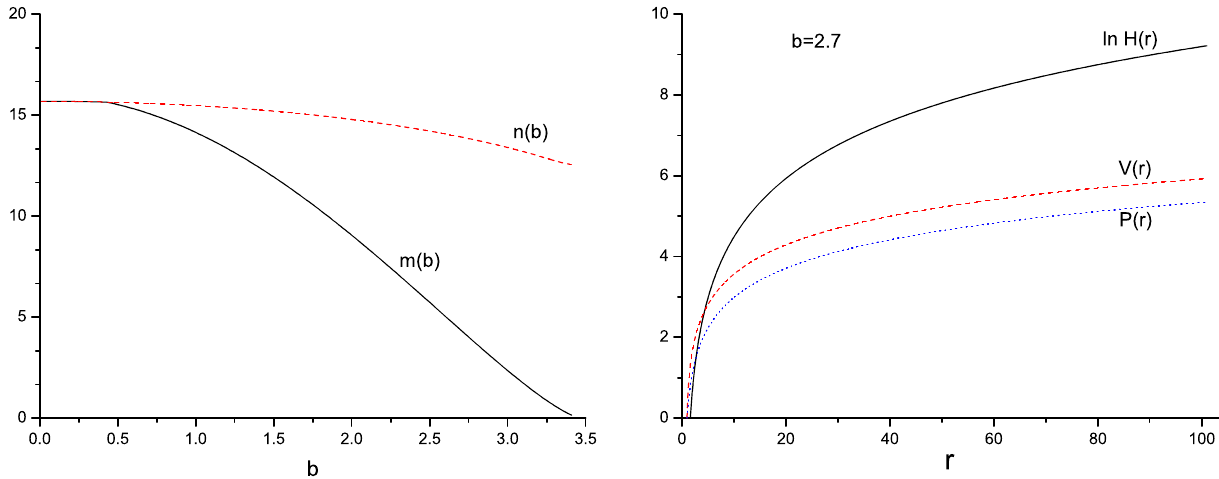
Fig. 1 Left: The rescaling parameters n ( b ) (dash curve) and m ( b ) (solid curve) versus b . Right: Numerical solutions for the functions ln H ( r ) (solid curve), V ( r ) (dash curve) and P ( r ) (dot curve) versus r for b = 2 . 7